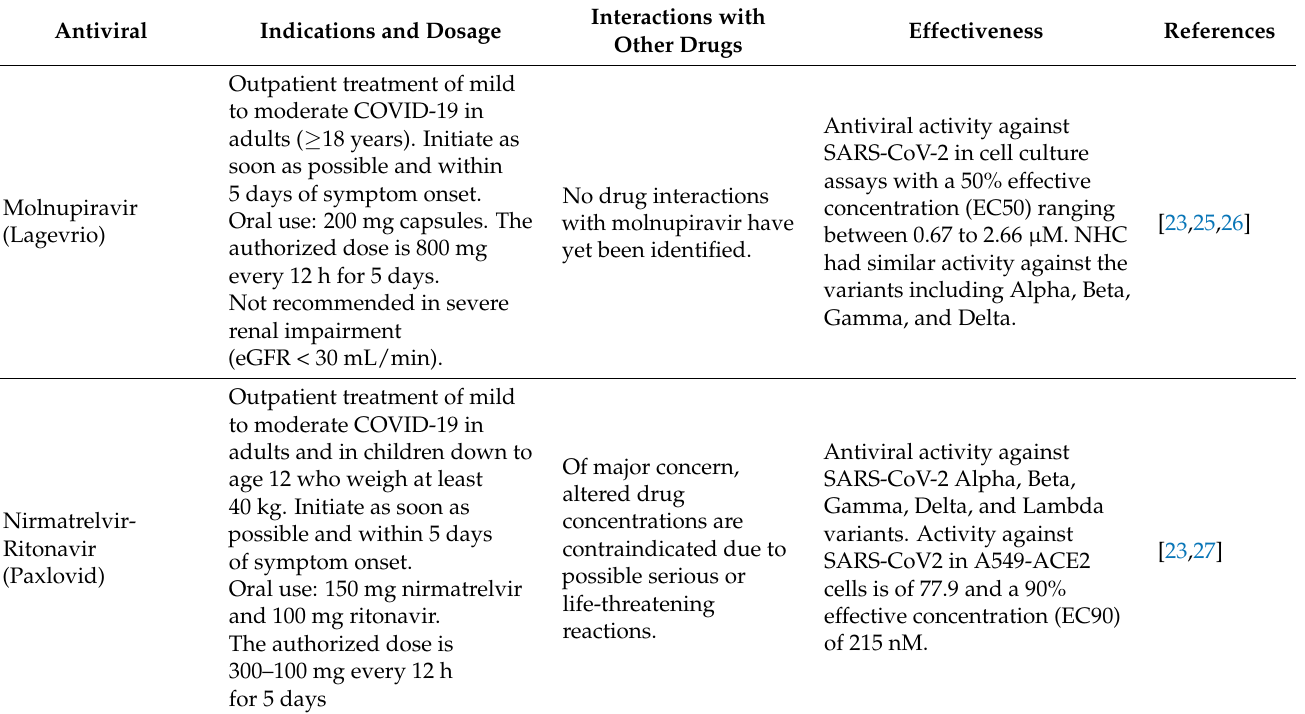
Table 1. Description of FDA-approved antiviral drugs. GFR: glomerular filtration